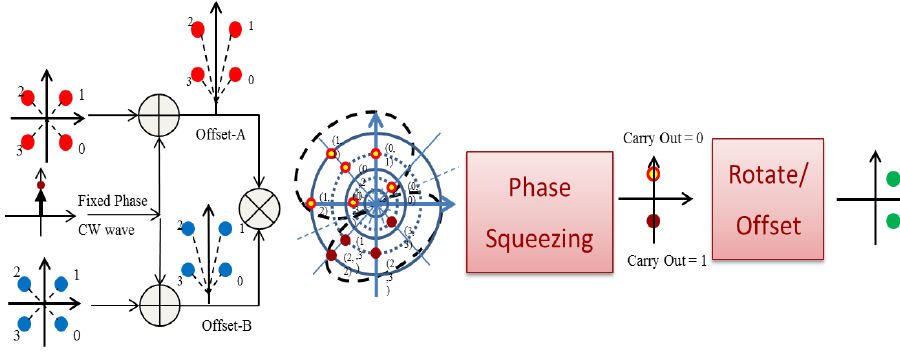
Figure 19. Proposed approach to compute carry-out of a PSK-encoded signal using phase halving and phase squeezing.